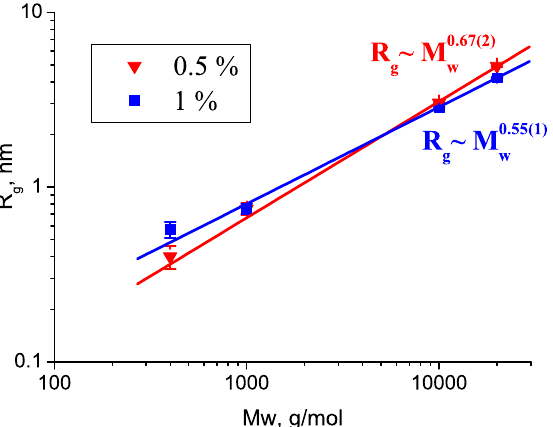
Figure 2. Dependence of the radii of gyration R g on the PEG molecular weight at different concentra- tions.